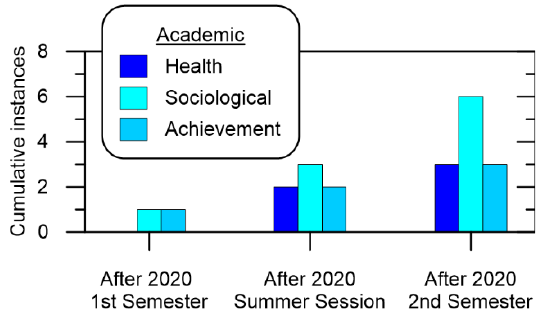
Figure 3. Cumulative Academic impact over time.